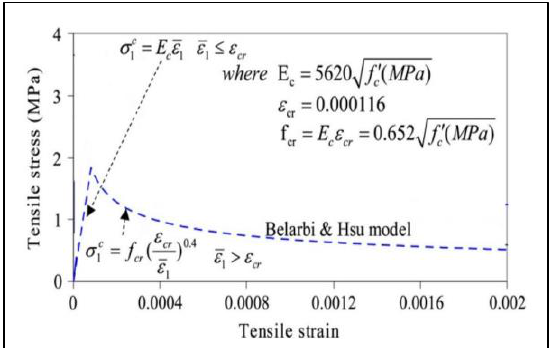
Fig. 2. Belarbi and Hsu model for tension behavior of concrete [9].